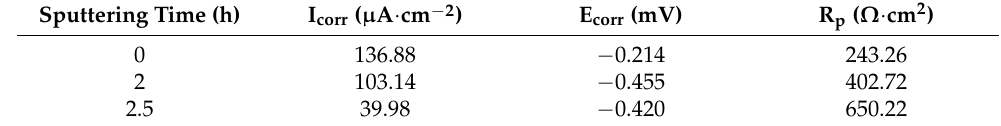
Figure 10. Polarization curves of CrN films sputtered by various time in 1 M H 2 SO 4 solution. Table 5. The corrosion current density (I corr ), polarization corrosion potential (E corr ) and polarization impedance (R p ) of CoCrNiSi 0.3 MEA with CrN films deposited for different sputtering times, tested in a 1 M H 2 SO 4 solution.